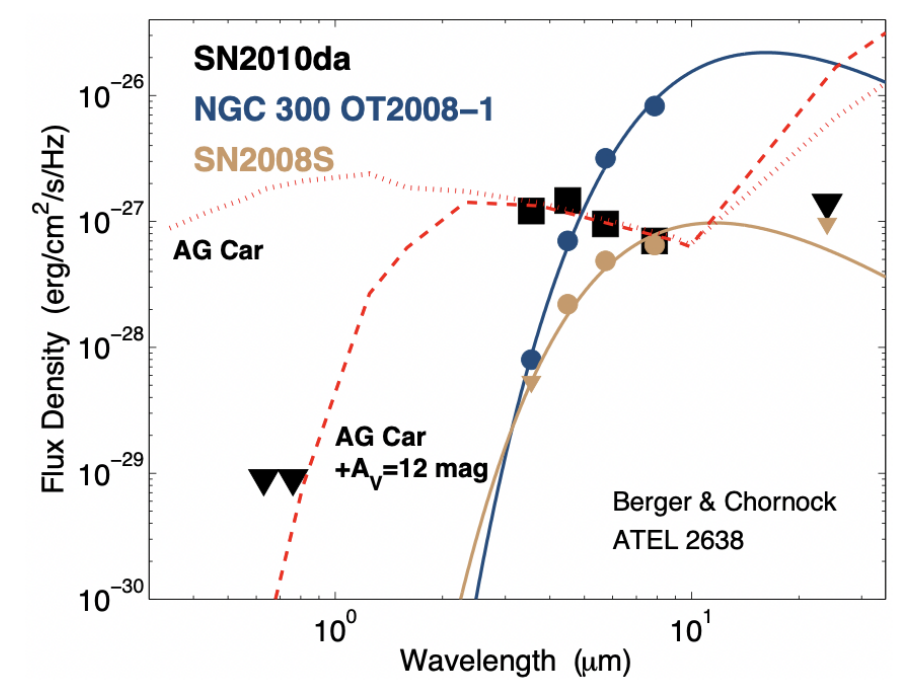
Figure 3. The IR spectral energy density (SED) of SN 2010da progenitor (black squares show measurements, black downward facing triangles show upper limits). The SEDs of two other optical progenitors, NGC 300 OT2008-1 and SN 2008S, are shown (in blue and brown, respectively) for comparison. The dotted red line shows the SED of the known LBV AG Car; the addition of 12 mag extinction is required for this SED to fit the observed fluxes of SN 2010da (dashed red line). Reproduced with permission from Berger and Chornock